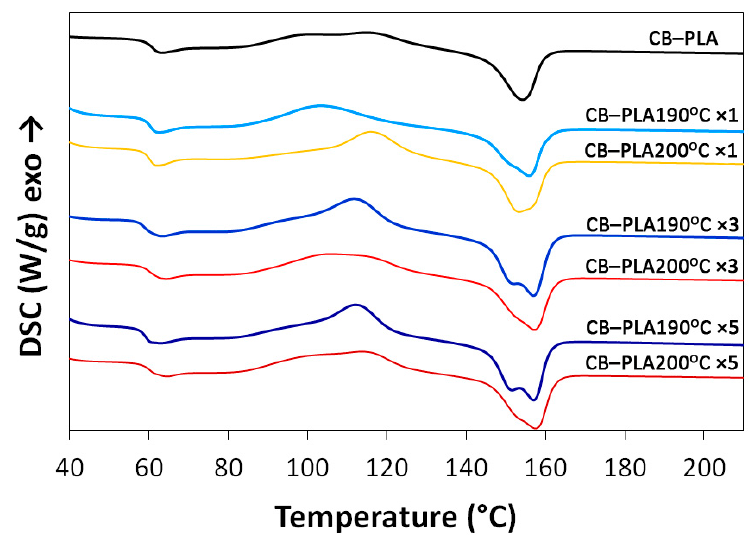
Figure 4. DSC measurements for studied materials. Table 2. DSC results for processed commercial CB–PLA